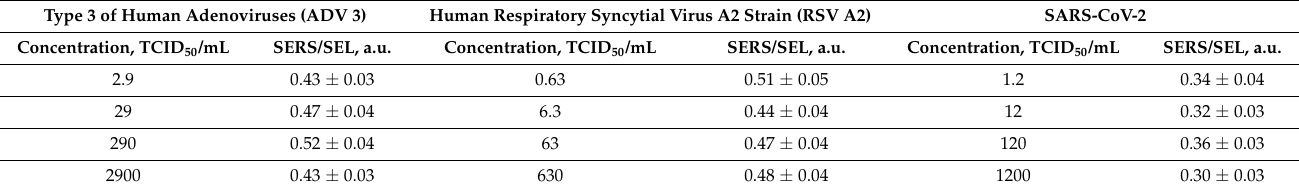
Table 1. SERS/SEL parameter for control viruses (ADV 3 and RSV 2) and SARS-CoV-2 at different